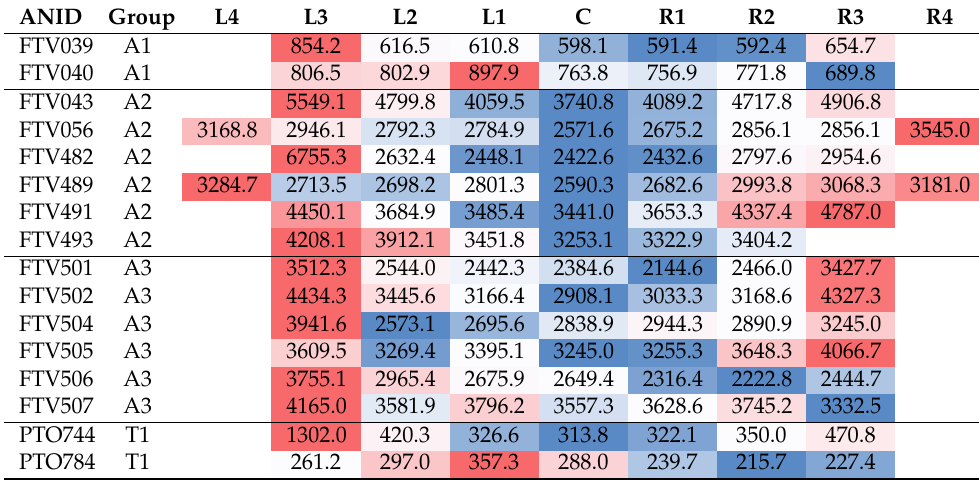
Table 2. Summary of the mean levels of barium. Red colors represent higher barium concentrations, blue colors represent lower